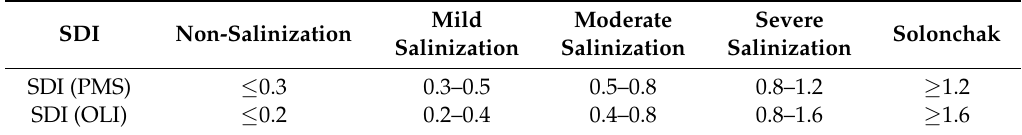
Table 4. Salinization classification standard.